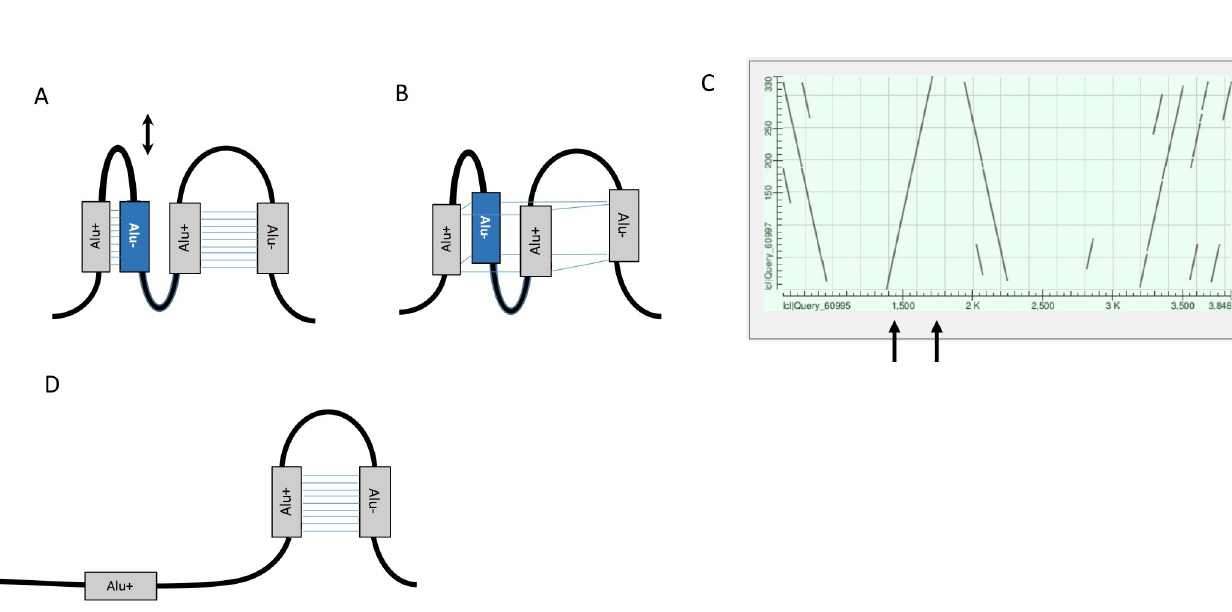
PLOS ONE | https://doi.org/10.1371/journal.pone.0261170 December16,